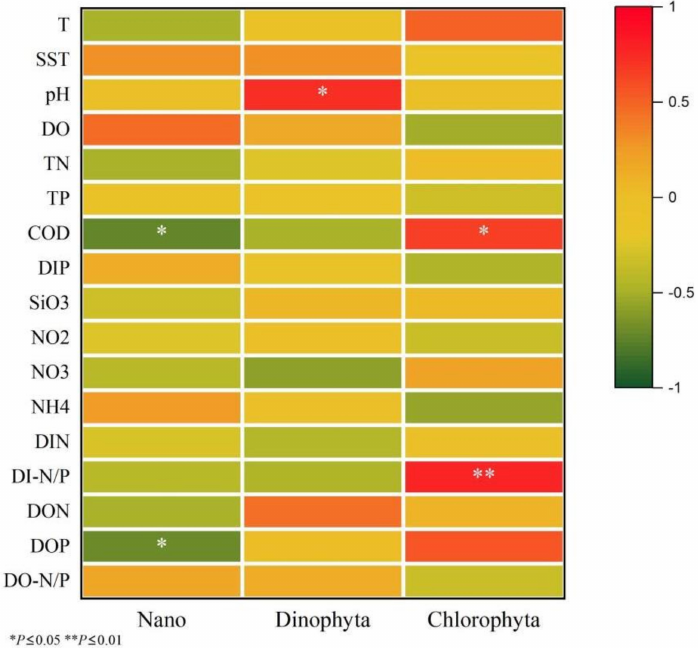
Figure 7. The relationship between the phytoplankton dominance and environmental factors in